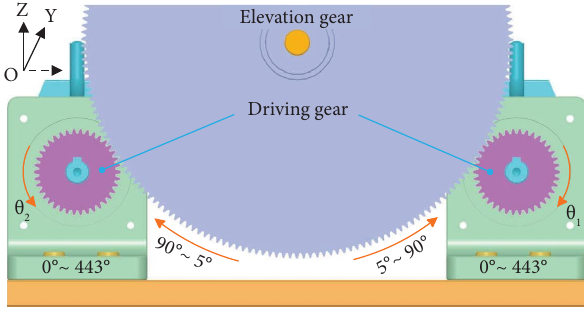
Figure 7: Schematic of dual-motor drive.